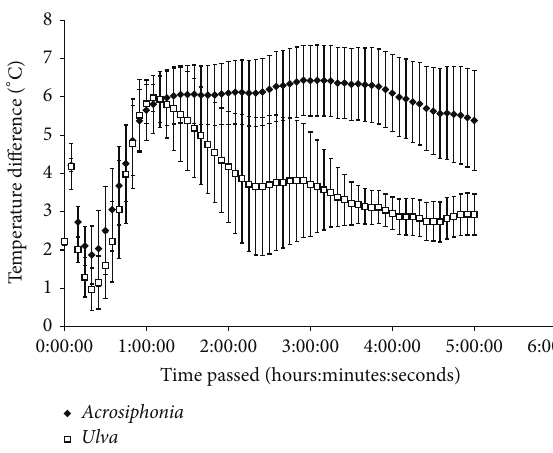
Figure 3: Average difference between an individual limpet’s drag force before and after removal of algal growth. Data are means ± standard deviation.